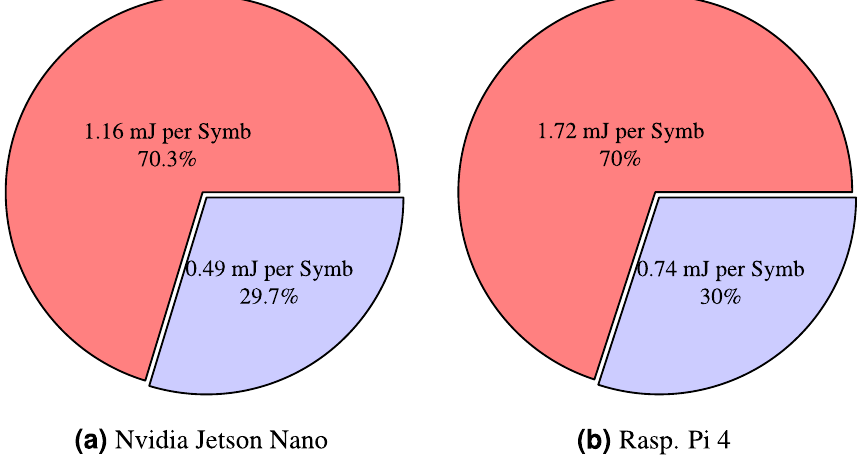
Figure 6. Energy consumption for Raspberry Pi 4 and Nvidia Jetson Nano. The blue section represents the energy consumption per recovered symbol when using the compressed model, and its relative energy cost is expressed as a percentage with respect to the sum of the energy consumed by both the original and compressed models. Likewise, the red section describes the energy consumption per recovered symbol when using the original model and its relative energy